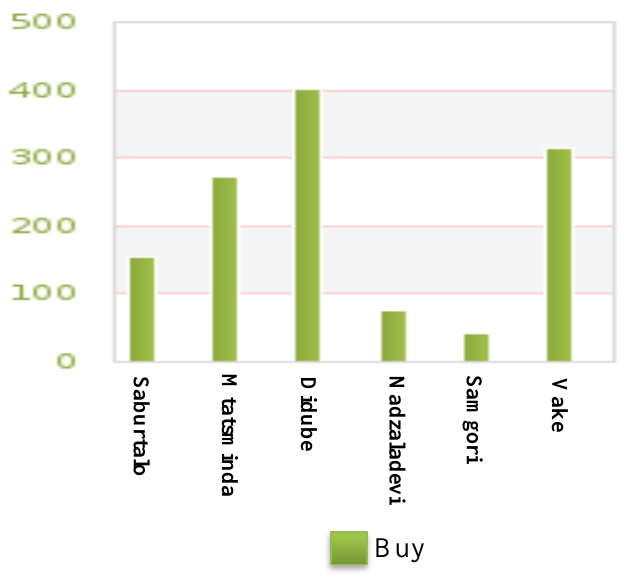
Fig. 7. Vacant land plots (cost per m 2 in US dollars ($) (Makler.ge,